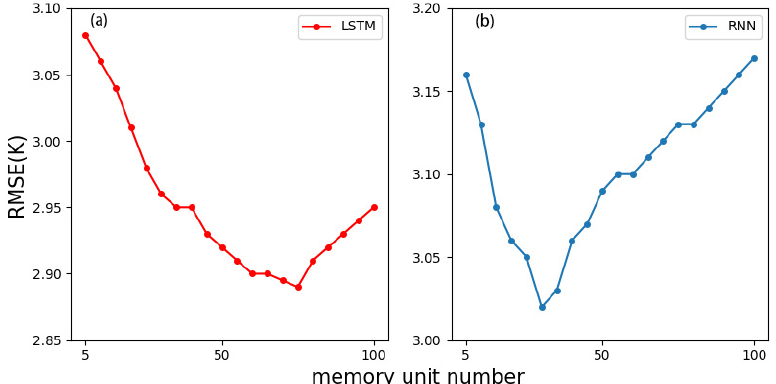
Figure 5. Relationship between the RMSE of the two models and the number of memory units in the model. ( a ) LSTM model, ( b ) RNN model.